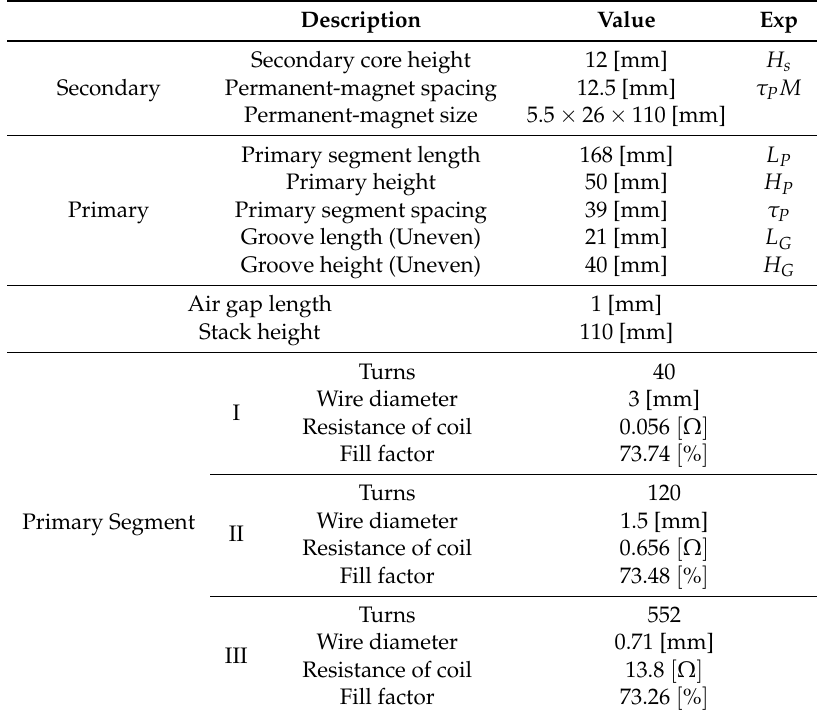
Table 2. Main Parameters of FL the FEM Model.